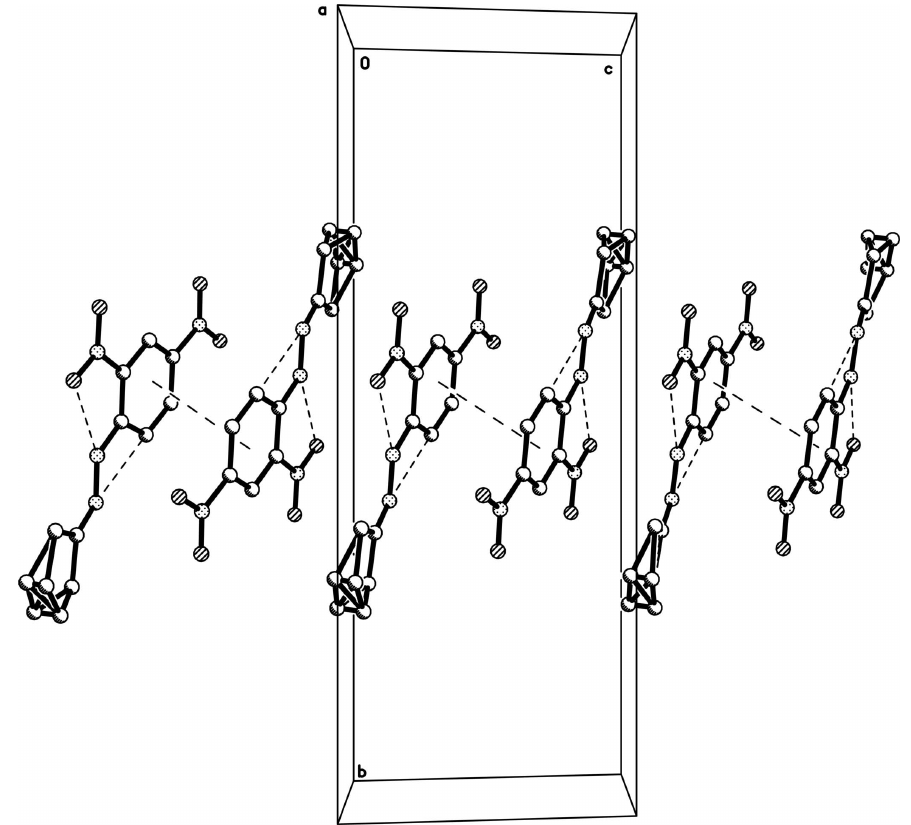
Figure 2 The view of the structure. The dashed lines indicate the N—H···O hydrogen bonds and C—H···N interactions as well as π – π ring electron